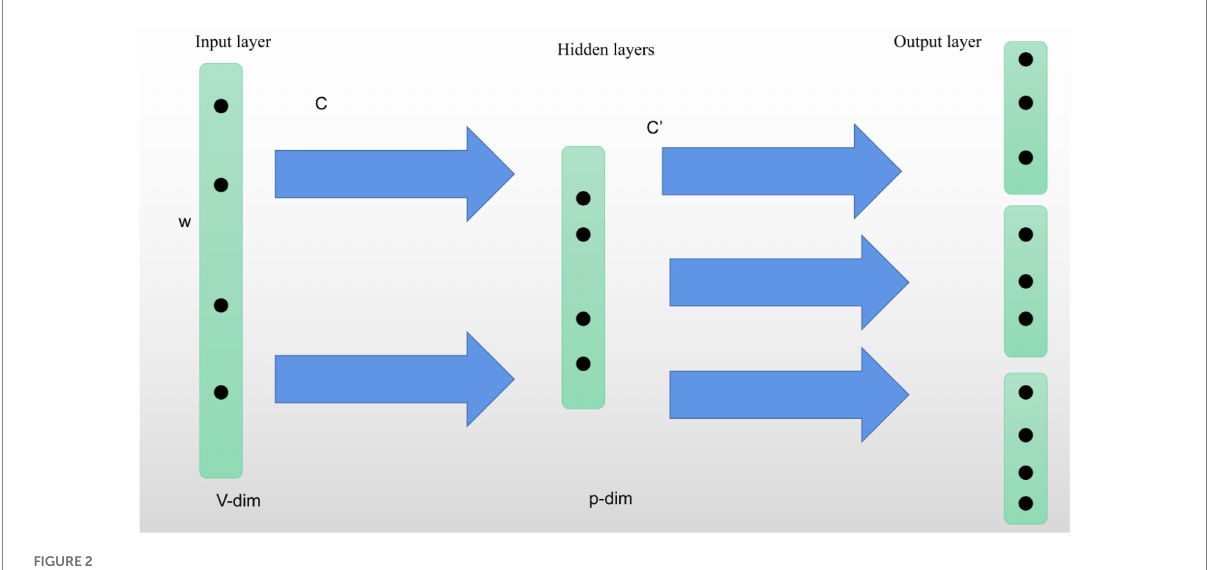
FIGURE 2 Skip-gram model specific model